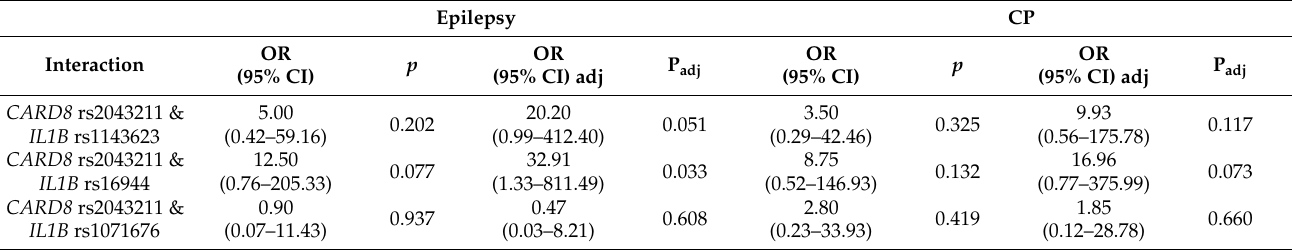
Table 6. The interaction of CARD8 and ILB polymorphisms with epilepsy or cerebral palsy. Epilepsy CP